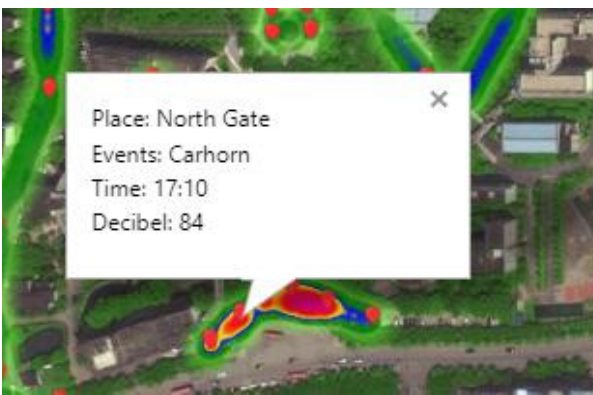
Figure 11. The monitoring platform.